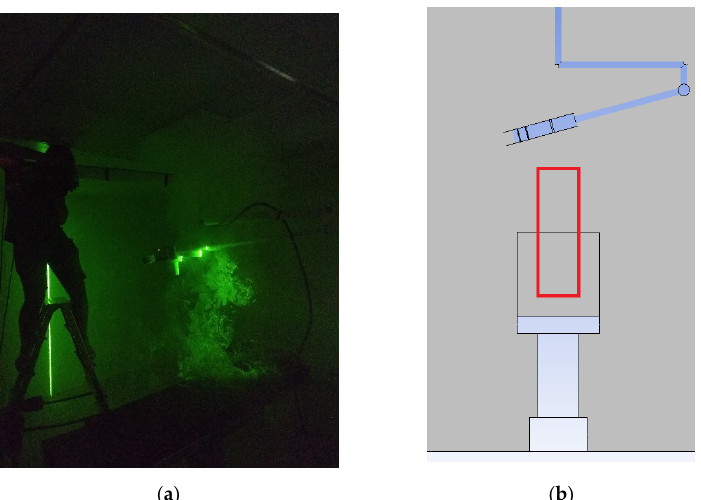
Figure 14. Creation of airflow velocity profiles: ( a ) smoke generation to the measuring area; ( b ) area measured by the PIV method.